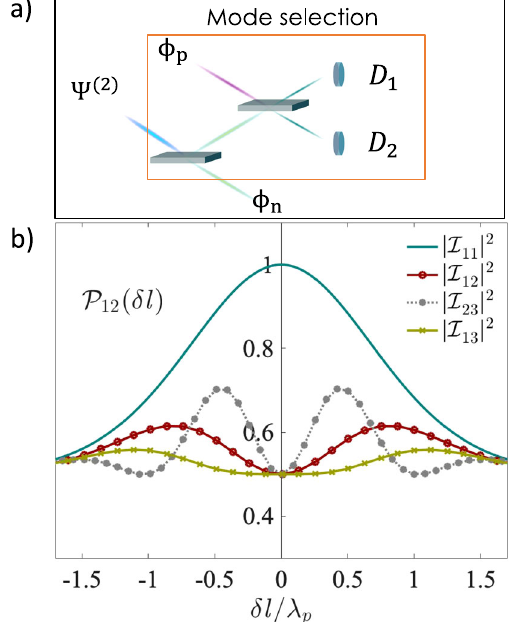
Fig. 4 ETM discrimination. a An incoming electron pair prepared in a superposition of ETMs is separated by a fi rst BS, then combined with a (shaped) probe mode ϕ p and fi nally measured in coincidence. b Coincidence outcomes of the probe with three possible incoming modes n ; p 2 1 ; 2 ; 3 f g , as a function of path difference δ l . The interference pattern displays increased response for identical probe and incoming